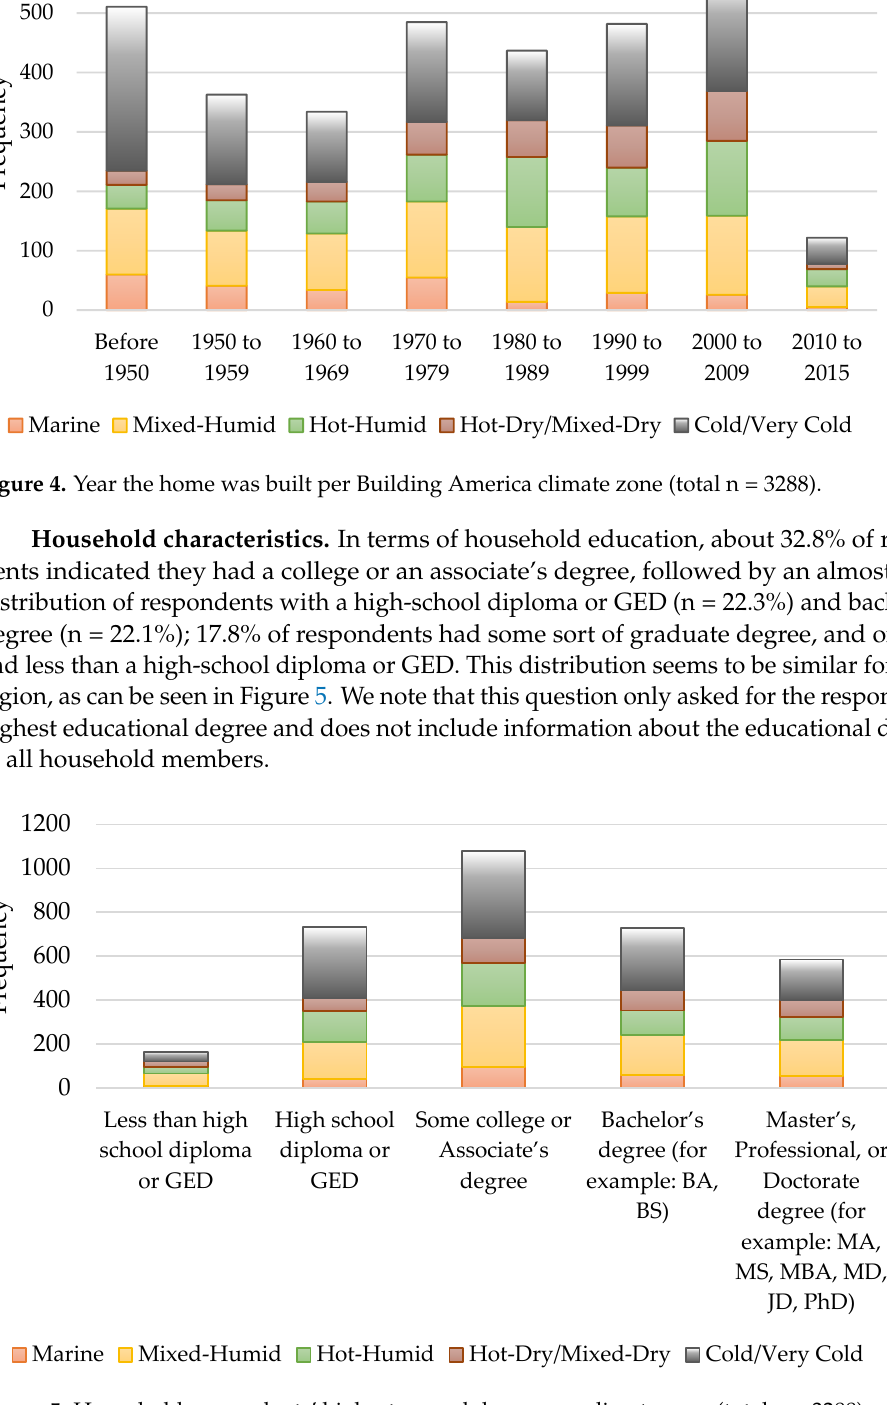
with 18.8% of respondents indicating to fit that income bracket. Income seems to vary per